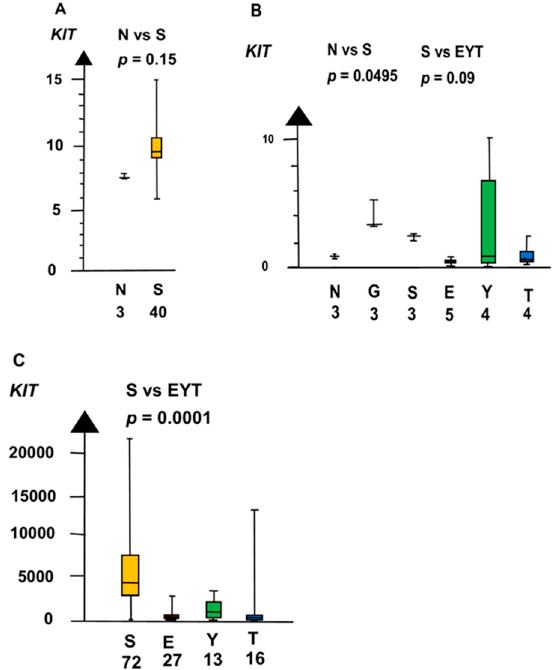
Figure 2. RNA expression of KIT in the three datasets ( A – C ) show that germ cell neoplasia in situ (G) and seminoma (S) had high RNA expression and that embryonal carcinoma (E), yolk sac tumor (Y), and teratoma (T) had a low RNA expression.